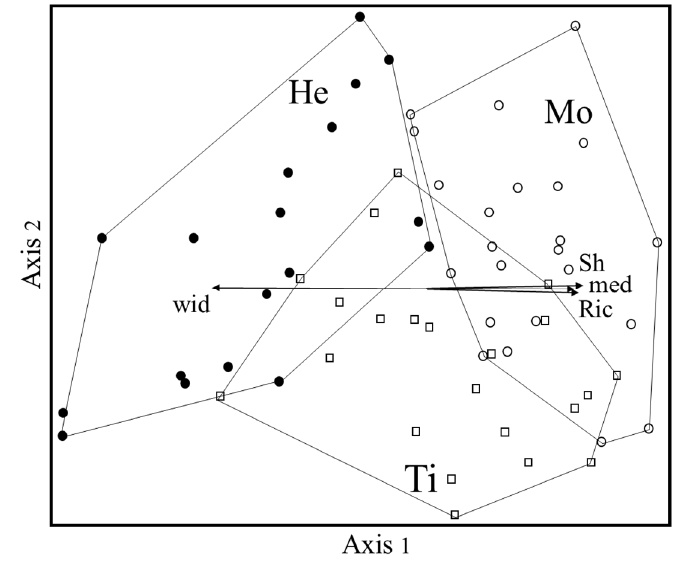
Figure 1. NMS ordination diagram. Ti = Tillage (open squares); He = Chemical herbicides (filled circle); Mo = Mowing (empty circles); med = Mediterranean taxa; wid = Taxa with wide distribution; Ric = Richness; Sh = Shannon index.